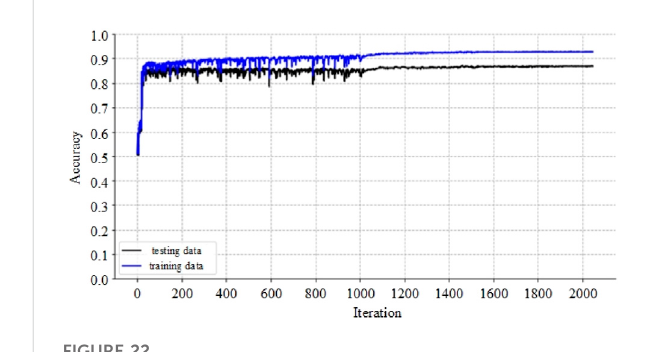
FIGURE 22 Accuracy of FFT-CNN-dropout network.